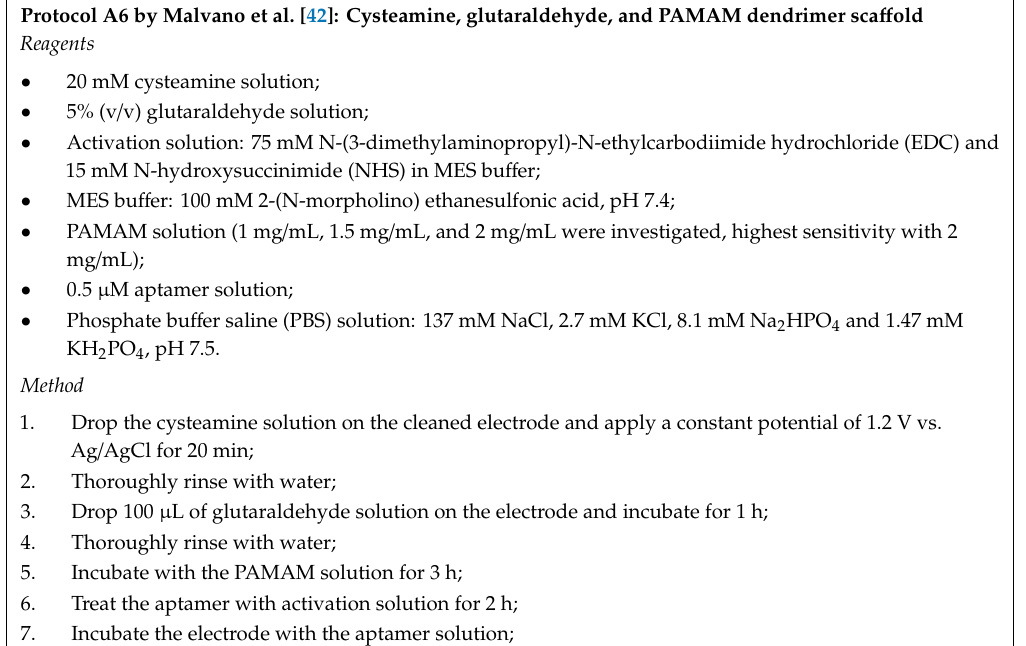
Protocol A6 by Malvano et al. [42]: Cysteamine, glutaraldehyde, and PAMAM dendrimer sca ff old